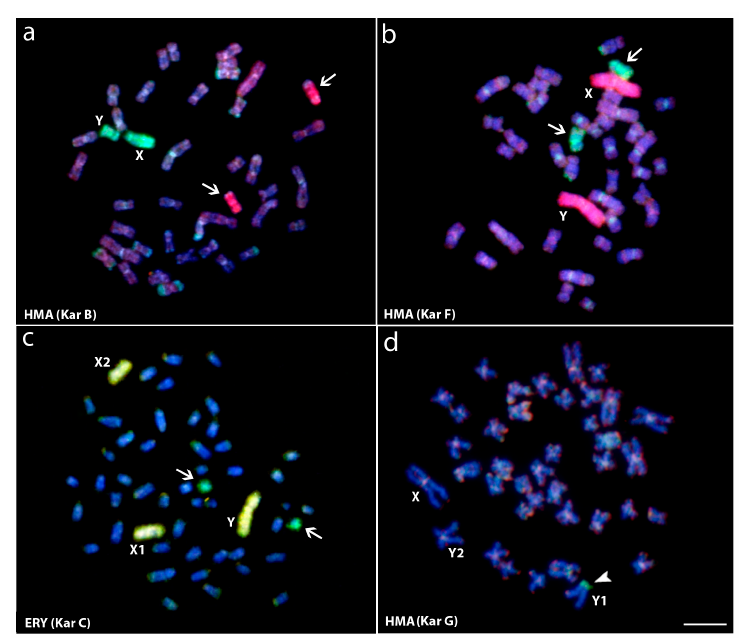
Figure 3. Whole chromosome painting (WCP) and comparative genomic hybridization (CGH) experiments to Hoplias malabaricus (HMA) and Erythrinus erythrinus (ERY) metaphase chromosomes. ( a ) Male HMA karyomorph B mapped with the X (green) and X 1 (red) probes from karyomorphs B and D, respectively; ( b ) Male of HMA karyomorph F mapped with the X (green) and the Y ( red ) probes from karyomorphs B and F, respectively; ( c ) Male metaphase of ERY karyomorph D mapped with the X (green) and the Y (yellow) probes, from HMA karyomorph B and ERY karyomorph D, respectively. The arrows indicate the non-homologous chromosomes painted with the sex-specific probes; ( d ) Male of HMA karyomorph G after CGH experiments showing the hybridization pattern of the male-derived probe (green) and female-derived probe (red). Arrowhead points to the male-specific region on the Y 1 chromosome ( d ). Bar = 10 μ m. Data from [25,46]. The lack of recognizable signals on the H. malabaricus karyomorphs B, C, and F sex chromosomes